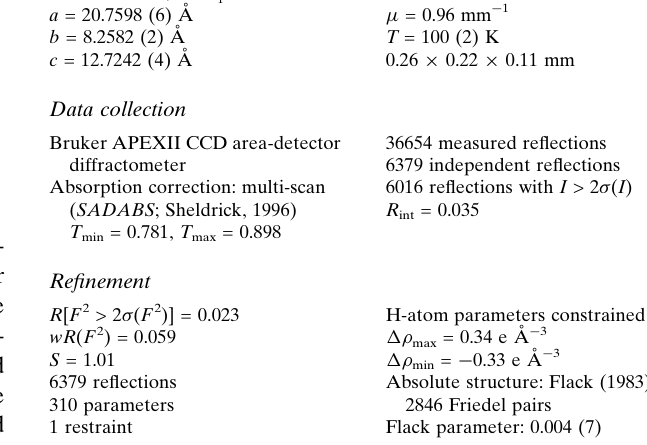
Data collection Bruker APEXII CCD area-detector diffractometer Absorption correction: multi-scan ( SADABS ; Sheldrick, 1996) T min = 0.781, T max = 0.898